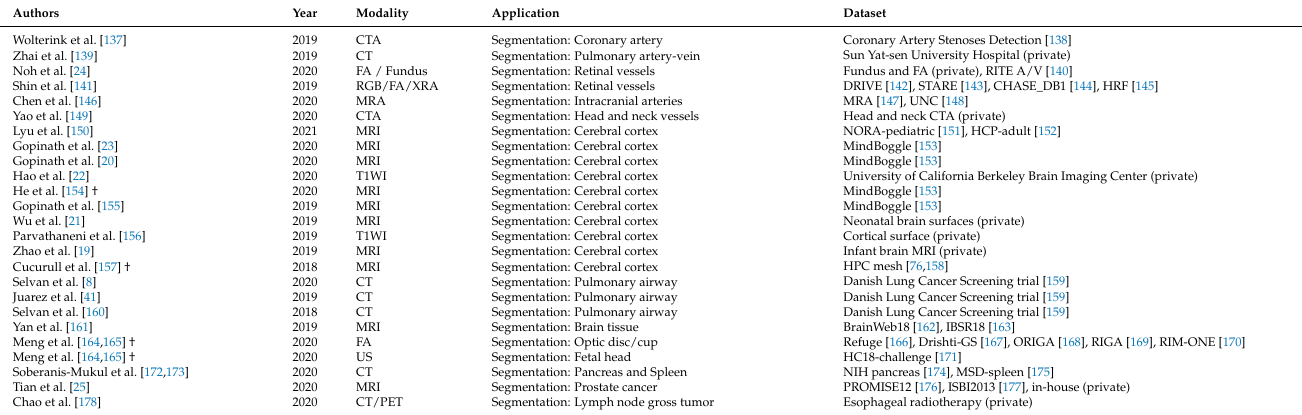
Segmentation: Lymphnodegrosstumor Esophagealradiotherapy(private) GCN with temporal structures for medical diagnostic analysis. † GCN with attention structures for medical diagnostic